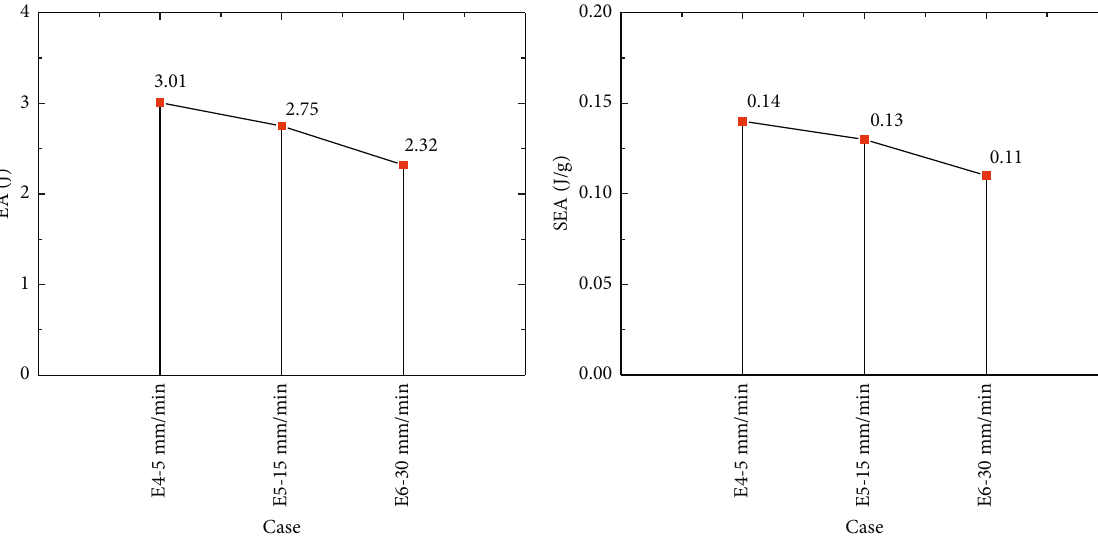
Figure 16: Comparison of different loading velocities for specimens: EA and